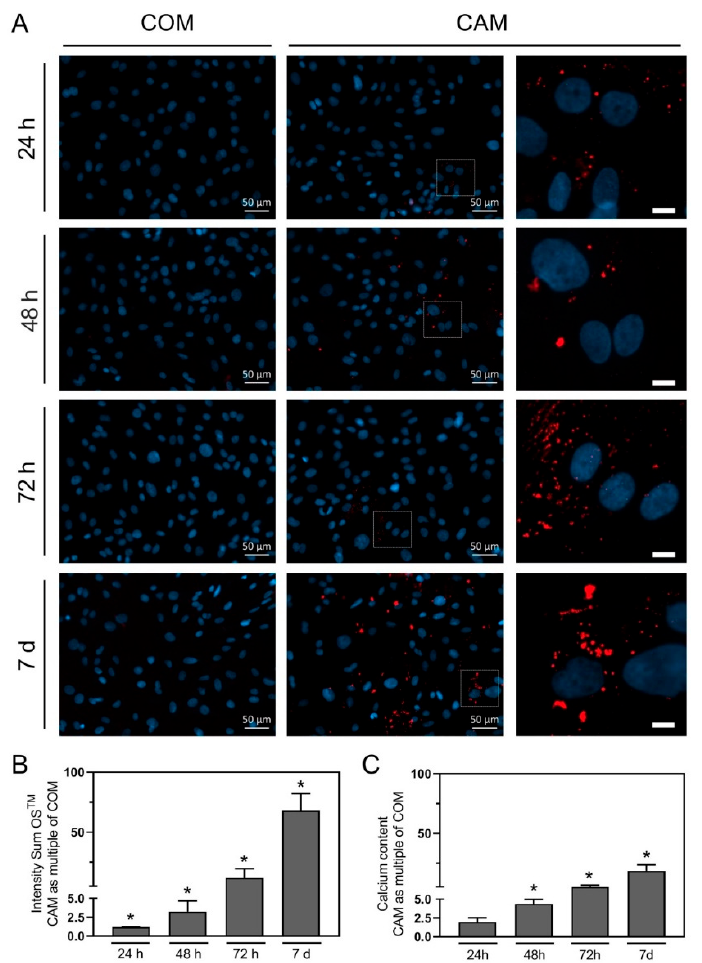
Figure 3. Hydroxyapatite staining and calcium quantification in vitro. ( A ) Representative images (merge) of rat vascular smooth muscle cells (VSMC) stained for hydroxyapatite with OsteoSense™680EX (OS TM ) (red channel) and cell cores with Hoechst33432 (blue channel), after stimulation with control medium (COM) or calcification medium (CAM) for 24 h, 48 h, 72 h and 7 d. The squares indicate areas of magnifications shown on the right side. ( B ) Quantification of hydroxyapatite via fluorescence signal, VSMC were stimulated for the indicated time periods with COM and CAM. ( C ) Quantification of calcification via photometric calcium assay, VSMC were stimulated for the indicated time periods with COM and CAM. If not stated otherwise, the scale bar indicates a 10 µm section, n ≥ 3, mean ± SEM, * p < 0.05 in comparison to stimulation with COM.